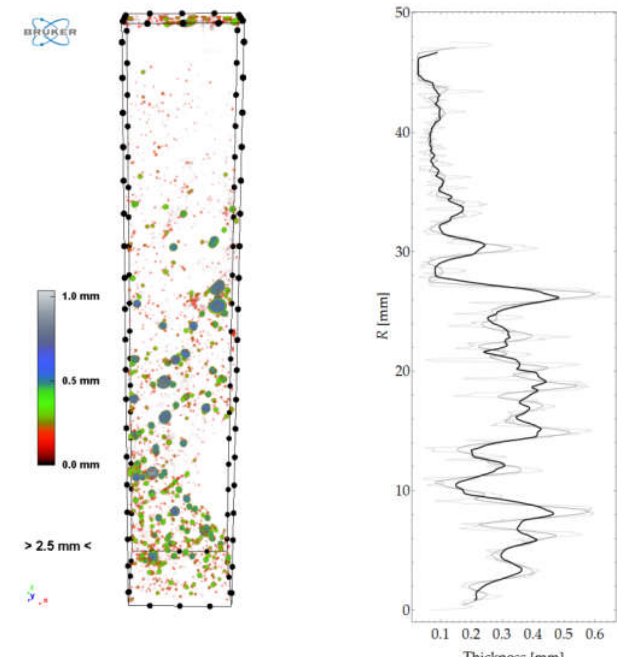
Figure 33. Spatial distribution of pore “thickness” and graph of mean thickness along sample height.